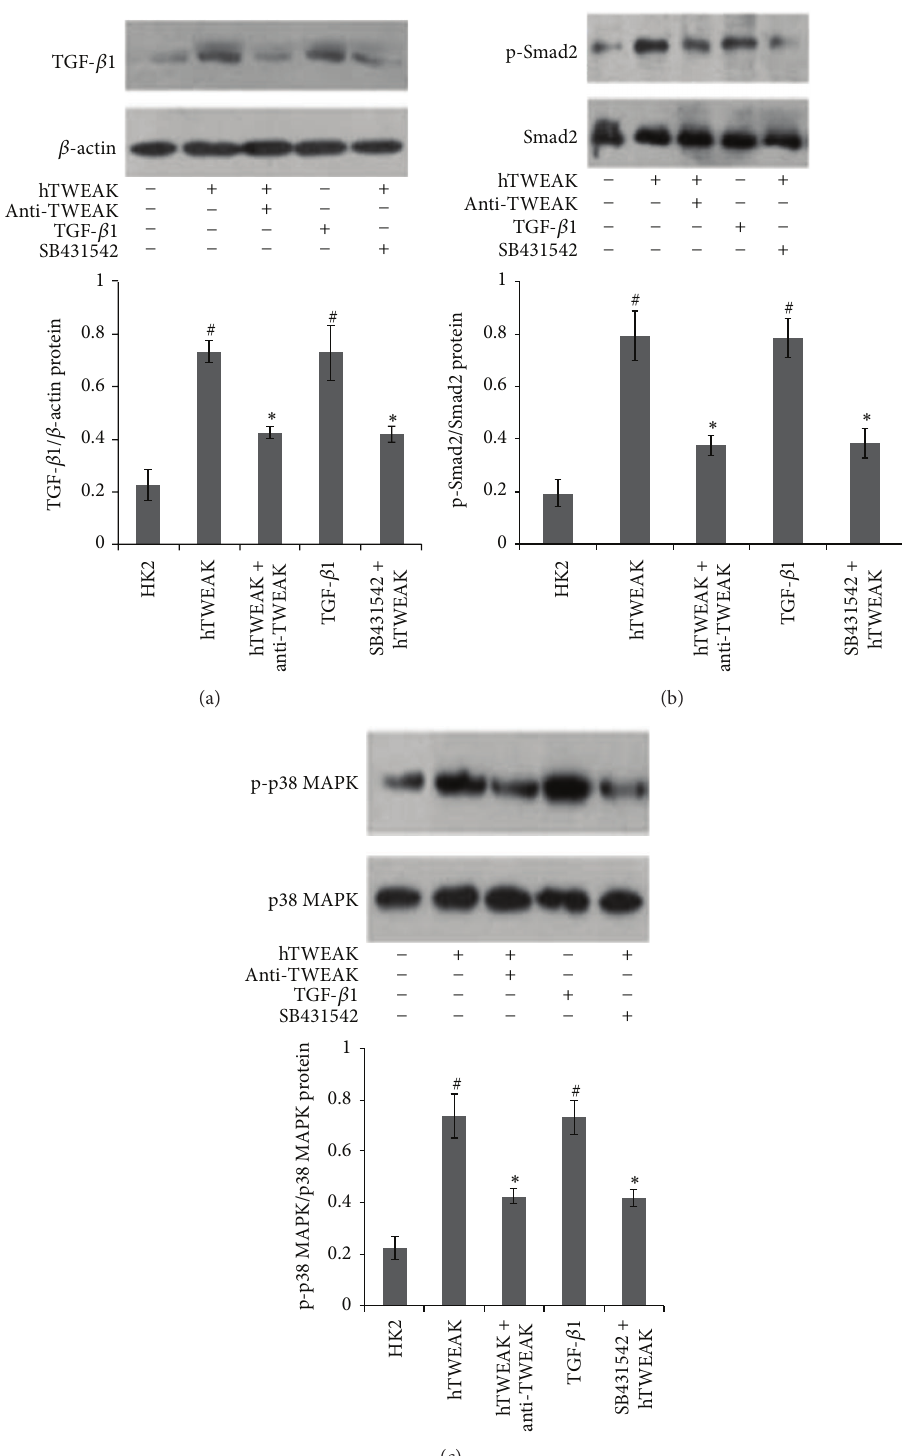
Figure 7: Effects of SB431542 on hTWEAK induced expressions of TGF- 𝛽 1, p-smad2, and p-p38 MAPK proteins in HK2 cells. Total cell lysates were collected for Western blotting to measure TGF- 𝛽 1 (a), p-Smad2 (b), and p-p38 MAPK (c) protein expressions. The representative experiments were presented at the top. The ratios of TWEAK/ 𝛽 -actin IOD, p-p38 MAPK/p38 MAPK IOD, and p-Smad2/Smad2 IOD were shown at the bottom. HK2: HK2 cells cultured without stimulation; hTWEAK: HK2 cells cultured with hTWEAK; hTWEAK+anti-TWEAK: HK2 cells cocultured with hTWEAK and anti-TWEAK mAb; TGF- 𝛽 1: HK2 cells cultured with TGF- 𝛽 1; and hTWEAK+SB431542: HK2 cells cultured with hTWEAK and SB431542. The error bars represent the standard deviation. Each experiment was repeated at least 3 times. # 𝑝 < 0.01 versus HK2 cells cultured without stimulation and ∗ 𝑝 < 0.01 versus HK2 cells cultured with